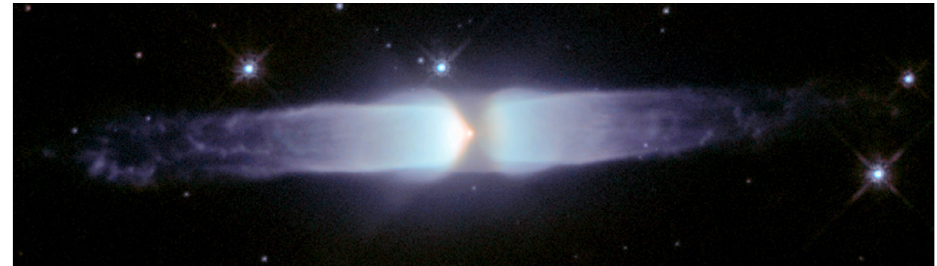
Figure 1. Hubble Space Telescope observation of Henize 3-401